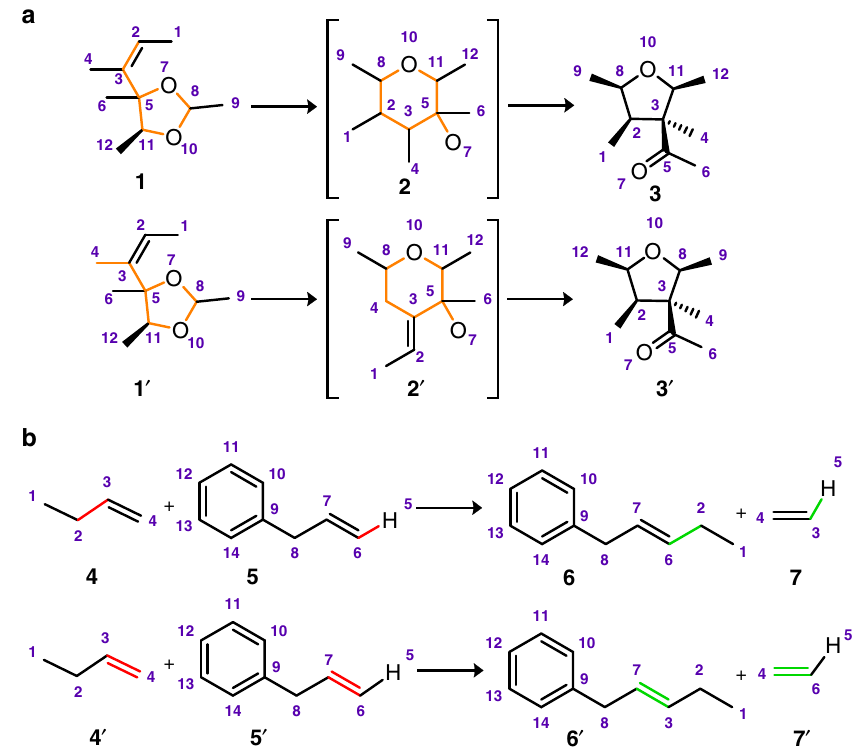
Fig. 4 Application of reaction heuristics. The example in a , illustrates the consequences of applying reaction heuristic [s] (see Fig. 2) in various places of the same substrate 1 in the Prins-Pinacol rearrangement 39,52 . In the top row, the heuristic is properly applied to the substrate (the substructure of the substrate recognized by the heuristic is marked orange) producing intermediate 2, which is then correctly mapped into product 3 with overall score = 3.5 (3 for disconnecting bonds 5 – 11, 3-H, and 7-H plus 0.5 for using the heuristic). In contrast, when the same heuristic is applied to the wrong part of the molecule (1 ′ ), it yields intermediate 2 ′ , which is incorrectly mapped into product 3 ′ with score = 4.5 (3 for disconnecting single bonds 4 – 8, 5 – 11, 7-H, additional 1 for converting double bond 2 – 3 into a single bond, and 0.5 for using the heuristic). The second example in b , illustrates the performance of the algorithm with and without the application of the metathesis heuristics (k in Fig. 3). (top row) Without the heuristics, the algorithm can identify the lowest- scoring isomorphic mapping by cutting only two single bonds — still, this solution is chemically incorrect. (bottom row) With the heuristics applied, the algorithm is not heavily (score + 4) penalized for cutting as many as four bonds (two σ and two π ) — application of the heuristics costs much less ( +